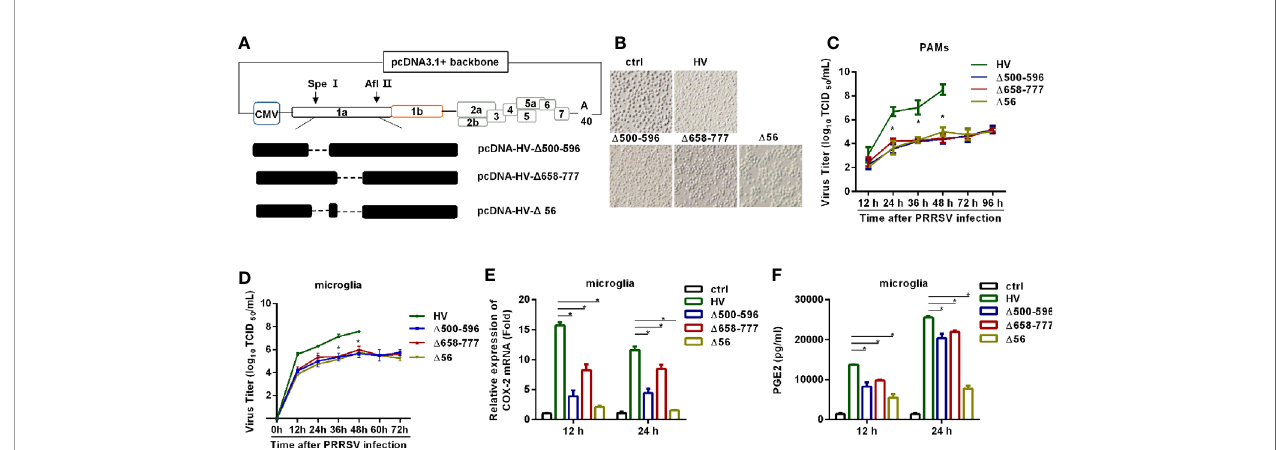
FIGURE 8 | HP-PRRSV with deletion mutant NSP2 impairs PGE2 production. (A) Strategy for the construction of the recombinant cDNA clone. The plasmid containing assembled genome of HV (pcDNA3.1-HV) was treated with Spe I and A fl II to get 439-6478 bp of the HV deleted mutant pcDNA3.1-HV [pcDNA3.1-HV ( D 439-6478)], and then the Q5 ® Site-Directed Mutagenesis Kit was used to generated deleted mutations. Finally, using HiFi DNA Assembly Master Mix, pcDNA-HV- D 500-596 [ D 500-596], pcDNA-HV- D 658-777 [ D 658-777], and pcDNA-HV- D 500-596/658-777 [ D 56]) were constructed. (B) Representative images of cytopathic effects induced by wt HP-PRRSV strain HV and the mutant viruses at 48 hours post-infection. (C, D) Supernatants were collected at indicated times post virus infection, and titrated for viruses using TCID 50 method. (E, F) Microglia were infected with HP-PRRSV strain HV and the mutant viruses at an MOI of 0.1. COX-2 expression was analyzed by real-time PCR (E) and PGE2 production was measured by ELISA (F) at 12 and 24 hours post-infection. Data are representative of three independent experiments (mean ± SEM). Statistical analysis was performed by Student ’ s t -test. *, P < 0.05